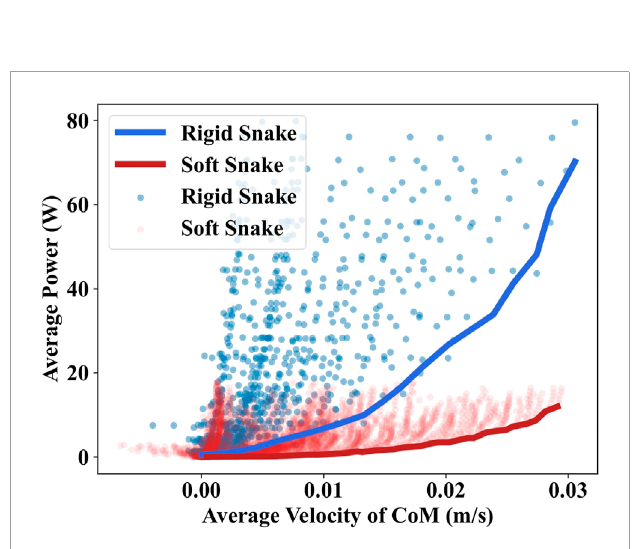
FIGURE 4 The grid search results of the gait equation controller for the soft and rigid snake robot. Each point in the scatter plot corresponds to a set of parameters in the grid equation controller. The fold line is the lower contour line of the same color scatter